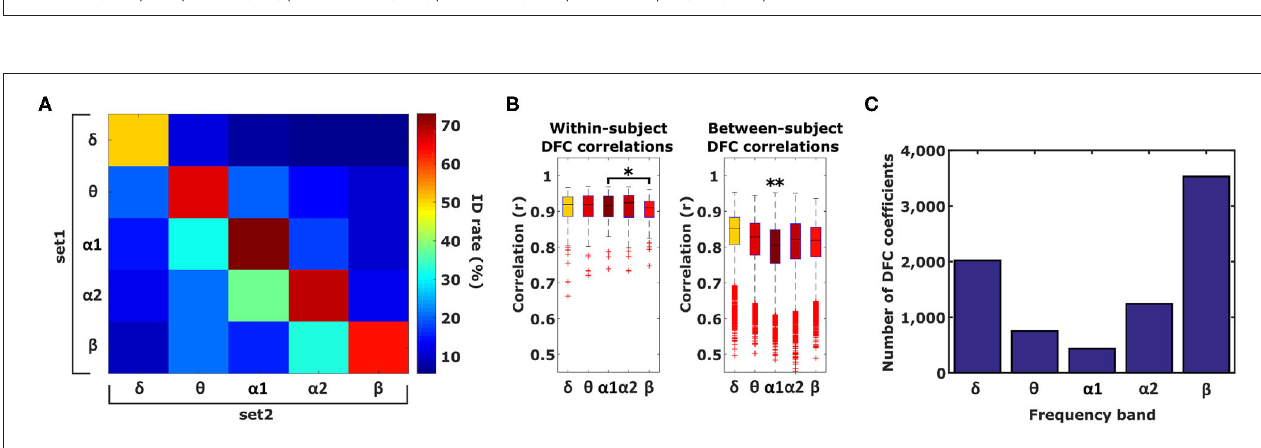
FIGURE 3 | Identification and Gender classification performance. (A) Identification performance across different frequency band combinations, diagonal elements indicate performance of within-frequency identification and off-diagonal elements indicate between-frequency identification. (B) Within-subject correlation in α 1 is only significantly higher compared to β . Between-subject correlation in alpha 1 is significantly lower compared to the other 4 frequency bands (one-tailed paired t -test, * p < 0.01, ** p ≪ 0.0001). Boxplots represent median (stripe), 25th and 75th percentiles (box), 1.5 times the interquartile range (whiskers), and outliers (crosses). Box colors correspond to the ID rate scale of (A) . (C) Number of DFC coefficients per frequency band that are statistically significant different between males and females based on a significance level of α < 3.76 × 10 − 7